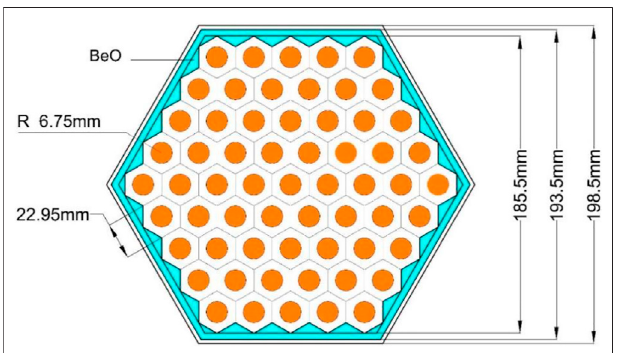
FIGURE 10 | SPALLER-100 fuel assembly.